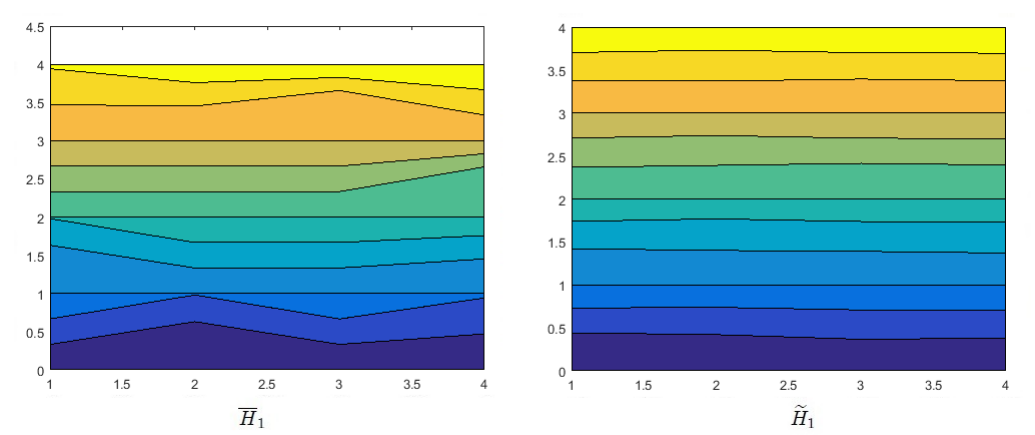
Figure 2. Area graphs of probabilities for H 1 .